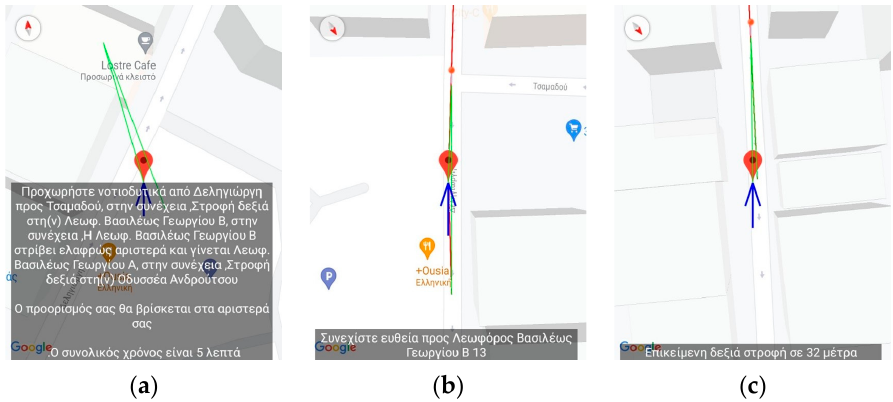
Figure 4. Application’s Training version—Starting the virtual navigation. The figures display the navigation messages issued from the application. The translation of the text is as follows: ( a ) Summary of the entire route, ( b ) “Keep moving straight ahead towards Vasileos Georgiou B 13 Avenue, ( c ) “Upcoming right turn in 32 m”.